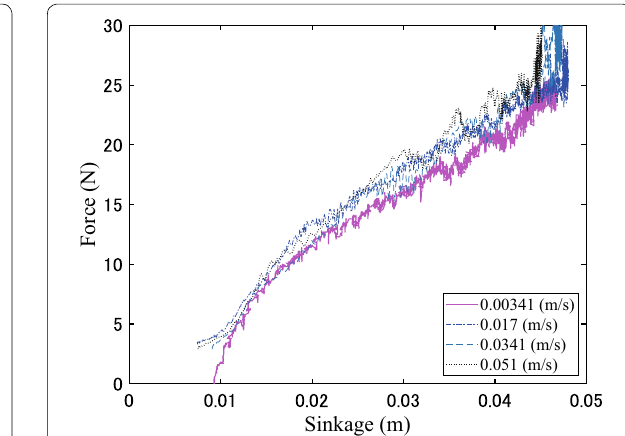
Fig. 11 Relationship between the wheel sinkage and resistance force at the different towing velocity